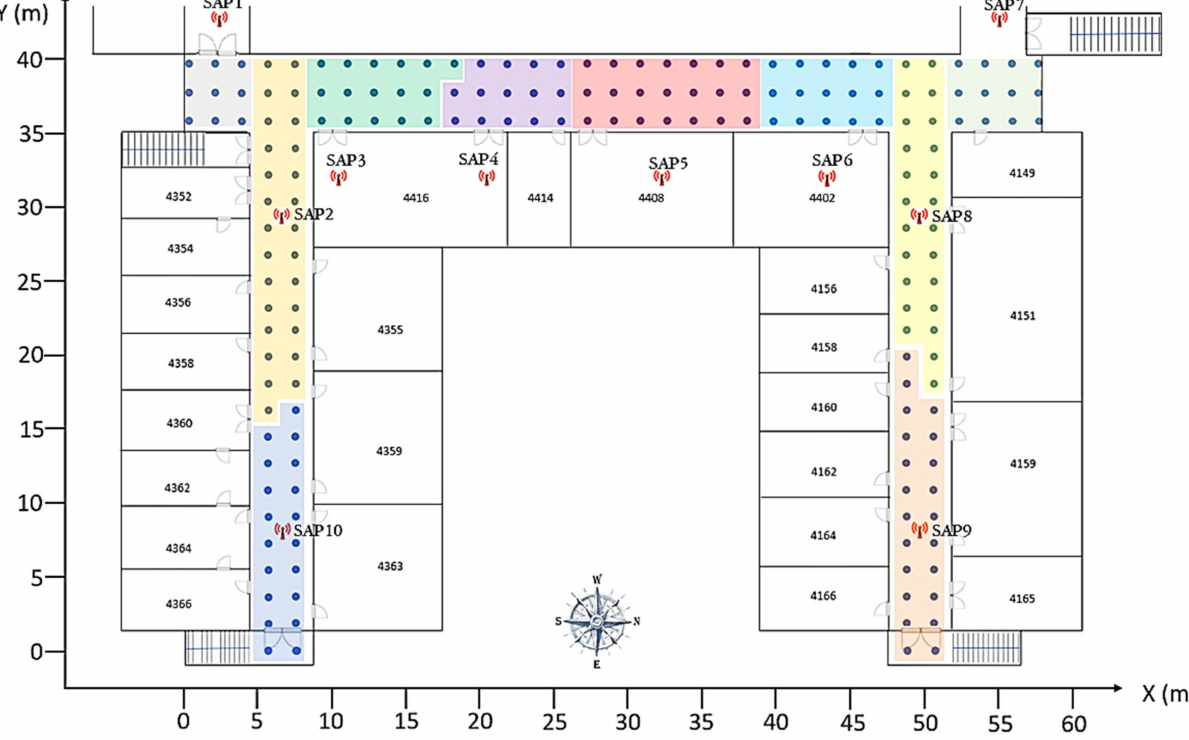
Figure 11. Experimental environment 2. Blue dots represent the RPs, and the size of the experimental field is 60 m × 40